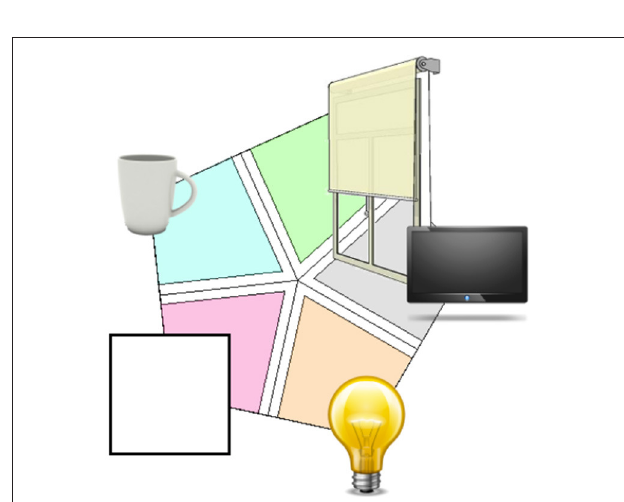
FIGURE 6 | Calibration of the toggle blinds